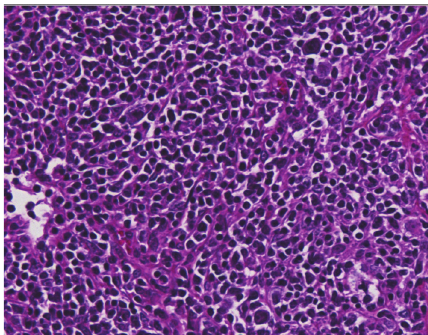
Figure 3: Plasmacytic cells labeled with MUM1 antibody. Section of lymph node biopsy, × 400 magnification.